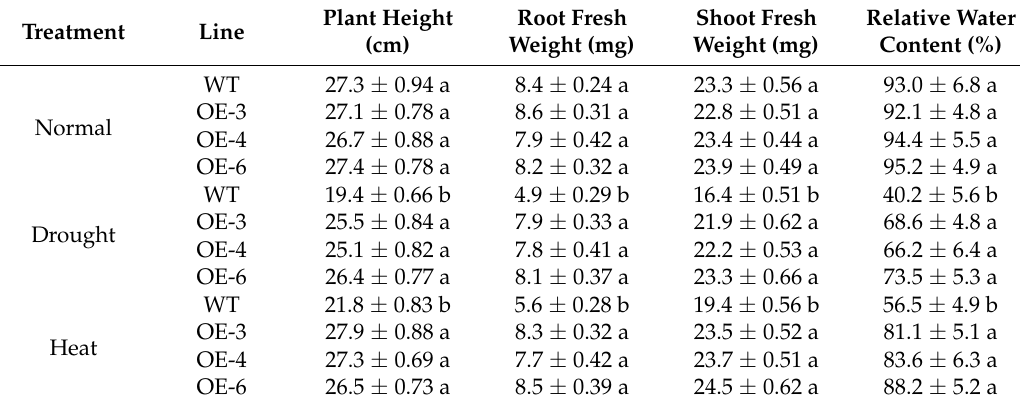
Table 1. Growth, biomass, and relative water content of the WT and transgenic rice seedlings grown under normal, heat, and drought stress